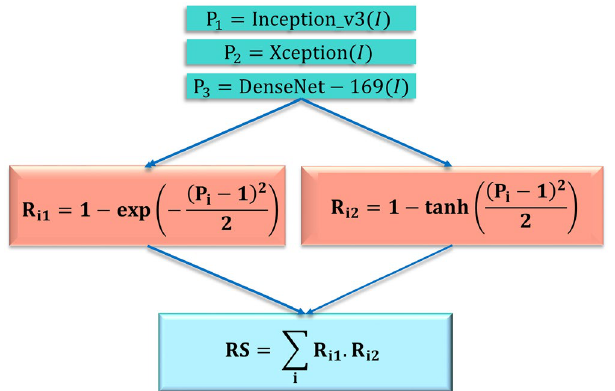
Figure 7. Mathematical steps of the proposed ensemble method using three CNN base models. I represents the input images; P represents the decision scores generated by the base learner and i represents the base learners: Inception v3 ( i = 1 ), Xception ( i = 2 ) and DenseNet-169 ( i = 3 ) (image has been made by R.K. using Google Slides).